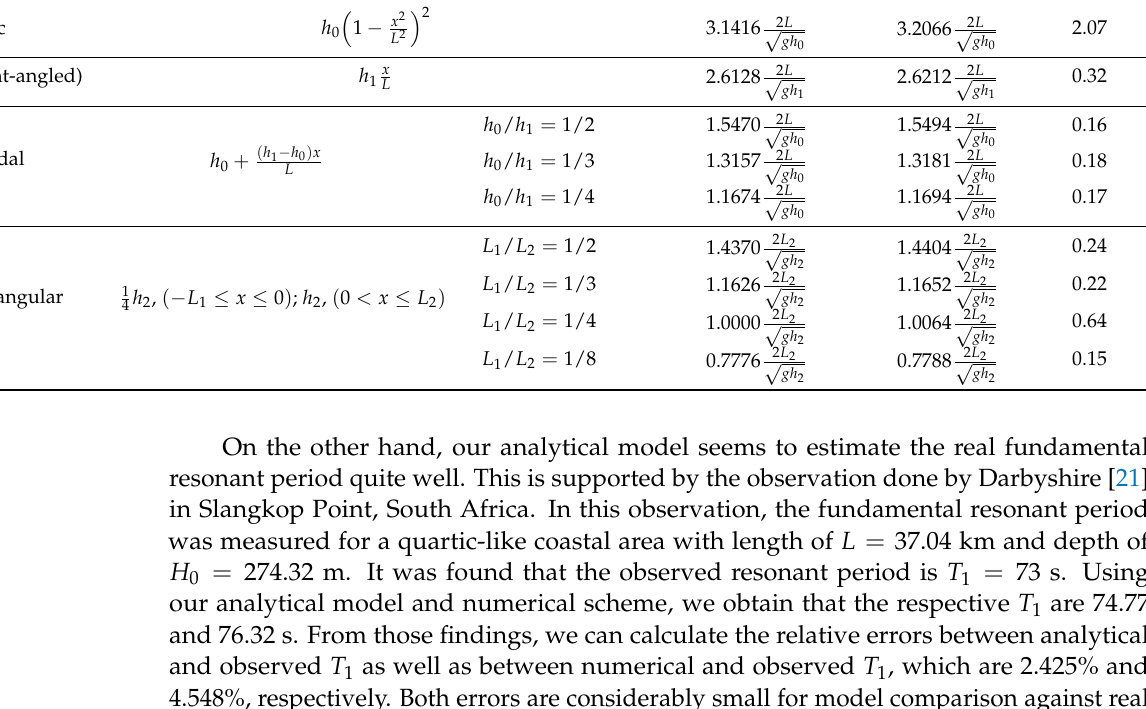
Table 1. The fundamental resonant period obtained for each type of semi-closed basin using analytical and numerical approach. Basin Type